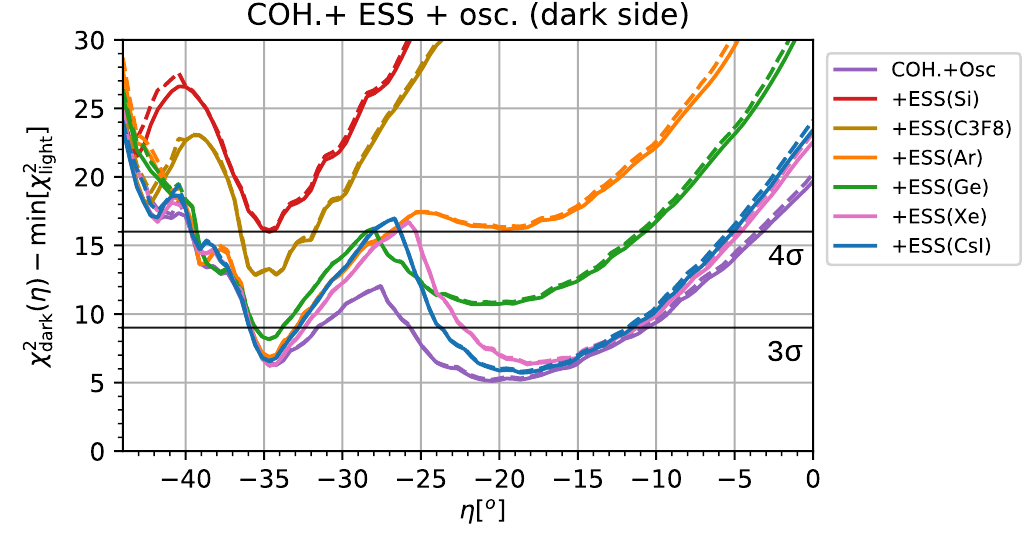
Figure 4 . Expected sensitivity to exclude LMA-dark by a CE ν NS measurement at ESS using different target materials. For dashed curves the off-diagonal (cid:15) η we minimize with respect to